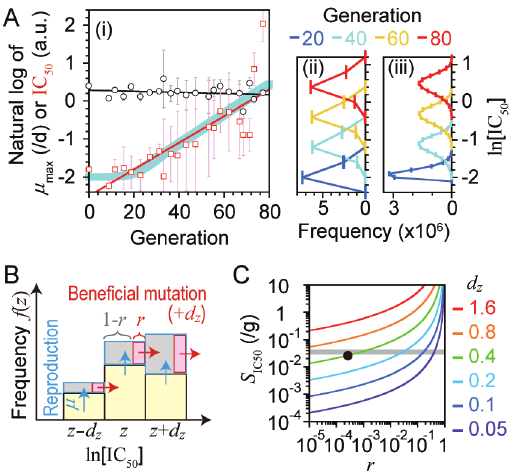
Figure 3. Quantitative analyses of the evolutionary changes by simple mathematical models. (A) Evaluation of the evolutionary changes in the maximum specific growth rate ( m m ax ) and the half- maximal inhibitory concentration (IC 50 ) until day 79. (i) Evolutionary changes in ln[ m m ax ] (black circle) and ln[IC 50 ] (red square), determined by the fitting shown in Fure S3 in File S1, with respect to the generation ( g ) of each round. The error bars show the standard error of the fitting estimates. The black and red lines show the linear regression of ln[ m m ax ] and ln[IC 50 ], respectively ( 2 0.0014 g + 0.28 and 0.035 g –2.5, respectively). The blue bold line is the change in the mean of ln[IC 50 ] calculated by the numerical simulation of the mathematical model of Eq. 1, using ( d z , r , N )=(0.4, 0.00023, 10 7 ), assuming a homogeneous population for the initial state. The source code of the simulation is shown in Appendix S1 in File S1. (ii and iii) Simulated evolutionary changes in frequency distributions of the cell population calculated by the numerical simulation using ( d z , r , N ) of (0.4, 0.00023, 10 7 : the same as the blue line in A-i) and (0.1, 0.04, 10 7 ), respectively. The vertical axis is ln[IC 50 ], as in A-i. (B) A conceptual scheme of the mathematical model of Eq. 1. See the text for explanation. Simply, the population shifts toward greater ln[IC 50 ] with a beneficial mutation rate per generation ( r ) and an effect size of a single beneficial mutation on ln[IC 50 ] ( d z ). The axes correspond to those of A-ii and A-iii. (C) The dependency of the evolutionary rate of ln[IC 50 ], i.e. , the slope of the red line in A-i ( S IC50 ), on the model parameters d z and r calculated from Eq. 2 using N =10 7 . The gray bold line shows the experimentally determined value ( S IC50 =0.035/ g ). The black point shows the value used for the simulation shown in